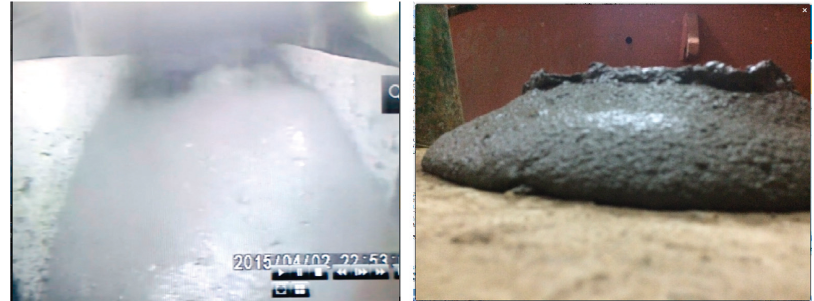
Figure 10: Improved morphology of the slag during the construction of EPBS. Table 6: Improved slump and permeability coefficient during